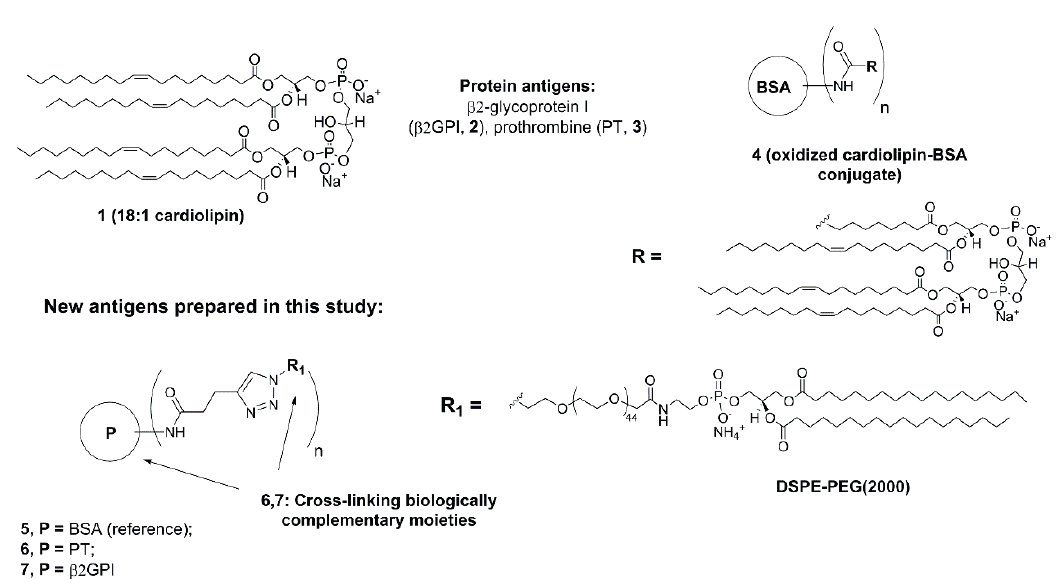
Figure 1. Antigens for detection of autoimmune Abs: CL, β 2GPI, PT; general structure